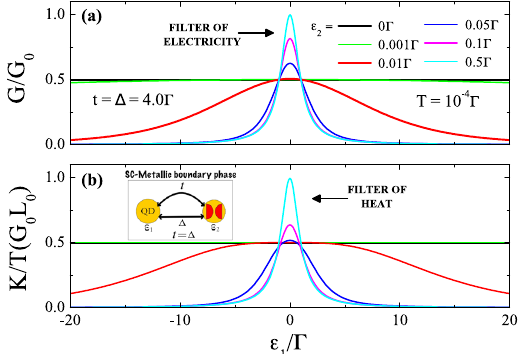
Figure 2. Electrical and thermal conductances of the system corresponding to SC-metallic boundary phase, t = Δ = 4 Γ : ( a ) Electrical conductance as function of the QD energy level ε 1 for several ε 2 values of the couplings between MFs. ( b ) Corresponding thermal conductance. For both cases the resonance at the Fermi energy ε 1 = 0 occurs if ε 2 ≠ 0. For ε 2 = 0 the conductance plateau is observed (see main text for the corresponding discussion). The inset shows the equivalent circuit with an auxiliary fermion d 2 constructed from MFs η A and η B (red half- circles).